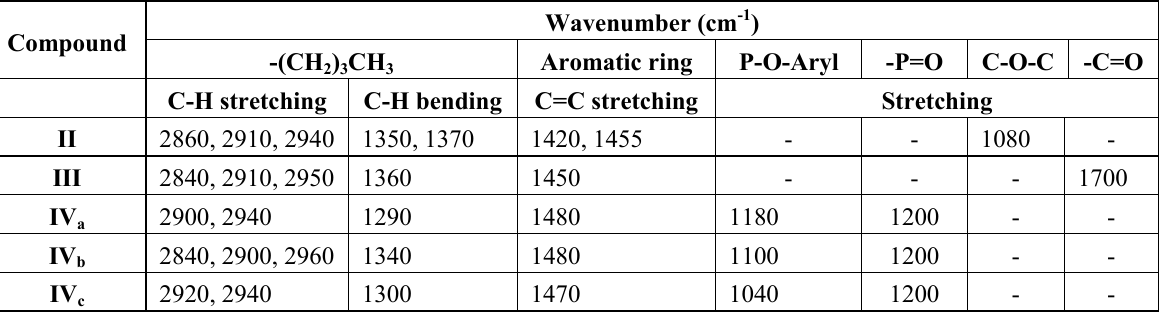
Table 6. FT-IR data of the titled